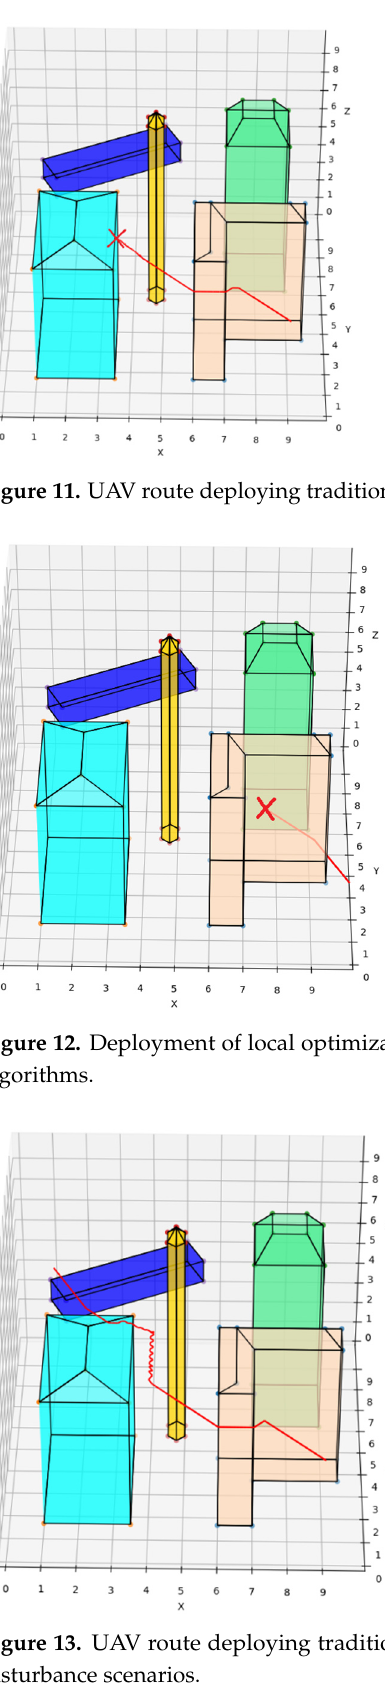
Figure 14. UAV route deploying REPARE algorithm in disturbance scenarios. 3.3. Risk Assessment of UAVs The larger the actual load of the UAV is, the more kinetic energy the UAV has to be paid when adjusting the sailing speed, altitude and attitude. To take a civil light quadrotor UAV as an example, according to the kinetic energy classification, the load and disturb- ance wind speed can be obtained as follows in Table 3. It should be noted that: 1. The level of “no disturbance” means no wind conditions, not absolutely no wind, but the wind speed is low, which has little impact on the UAV. It only needs to be consid- ered in the case of an extreme load of the UAV. 2. Under severe disturbance, it is possible that the equivalent mass of the disturbance force in the z-axis direction (heavy rain) exceeds the maximum load of the UAV. Thus, the flying stops. Table 3. Schematic representation of the degree of adjustment of the resilience system. Load/Disturbance